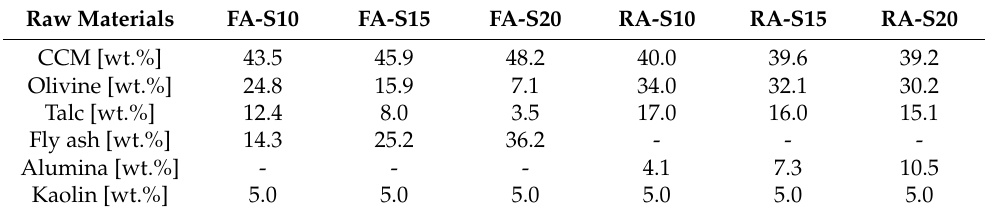
Table 2. Composition of all designed mixtures from raw materials. Raw Materials